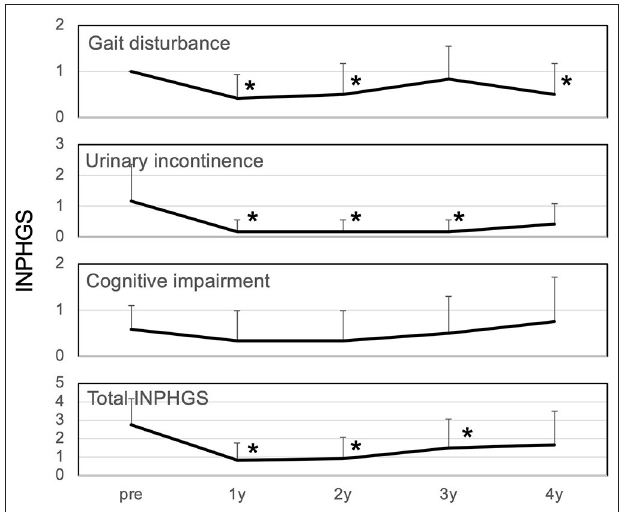
FIGURE 1 | Changes in iNPH grading scale over 4 years. All symptoms improved at 1 year postoperatively. Gait disturbance and urinary incontinence improved significantly at 1, 2, and 4 years postoperatively and at 1, 2, and 3 years postoperatively, respectively. The improvement in cognitive impairment lasted for 1-2 years but returned to the original level at 4 years. Changes in the INPHGS were assessed using Wilcoxon’s signed-rank test. INPHGS, idiopathic normal pressure hydrocephalus grading scale. Asterisks indicate significant differences compared to preoperative values ( p < 0.05).